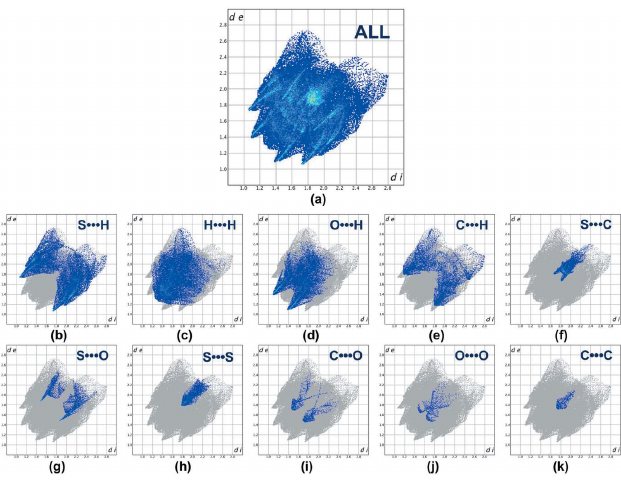
Figure 4 Full ( a ) and individual ( b )–( m ) two-dimensional fingerprint plots showing the ten intermolecular contacts present in the crystal structure.